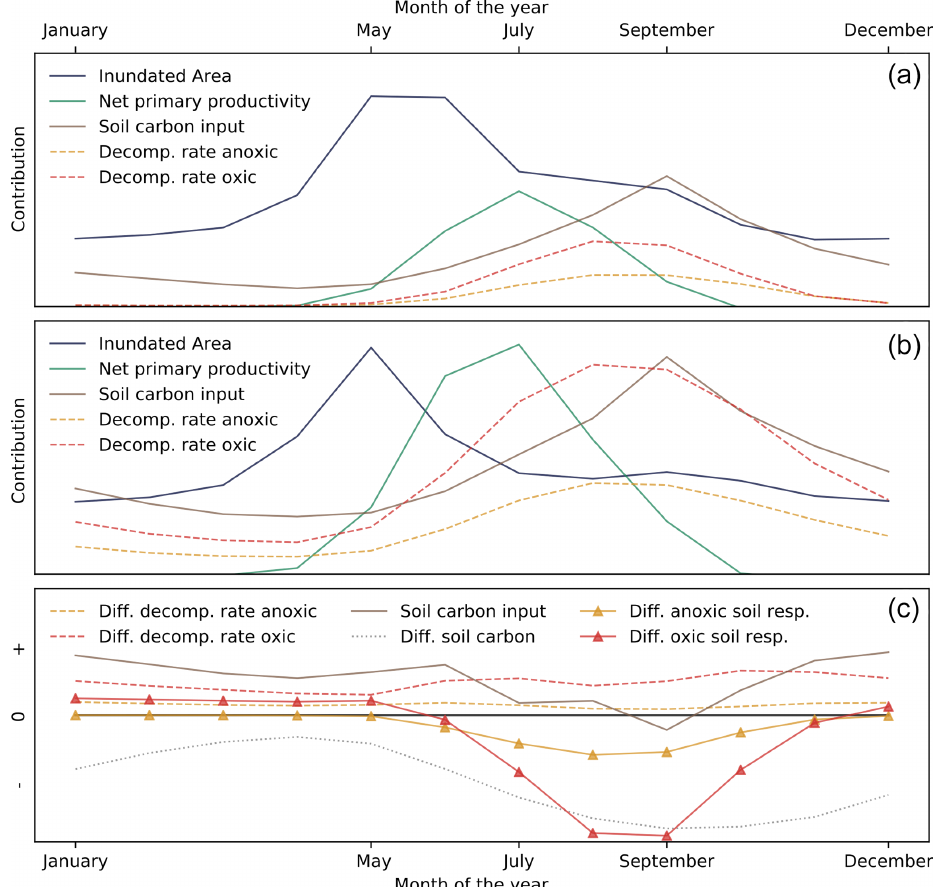
Figure 12. Seasonal dynamics in inundated areas. (a) Annual cycle of inundated areas (blue lines), NPP (green), carbon input into the soil (brown), and decomposition rates under anoxic conditions (yellow) and under oxic conditions (red) in permafrost-affected regions that feature a large wetland extent. Shown (qualitatively) are the seasonal dynamics that are representative for the year 2000, before the increase in atmospheric GHG concentrations. (b) Same as (a) but representative for a given forcing peak. (c) Differences (qualitative) in anoxic (dashed yellow lines) and oxic (red dashed lines) decomposition rates, carbon input into the soil (solid brown line), organic matter within the active layer (dotted grey line), and anoxic (solid yellow line) and oxic soil respiration rates (solid red line) after and before a given forcing peak.